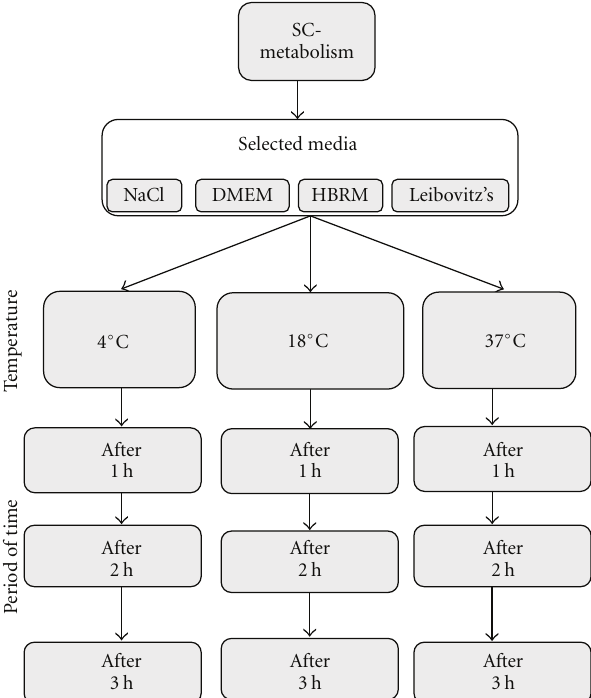
Figure 1: Conditions for testing the metabolic activity of Schwann cells in vitro after incubation in selected media including saline, DMEM with 10% FCS, HBRM, and Leibovitz’s medium. Sciatic nerves were incubated in these selected media at 4 ◦ C, a room temperature 18 ◦ C and 37 ◦ C. For each temperature condition, Schwann cell metabolism was determined after 1hrs, 2hrs, and